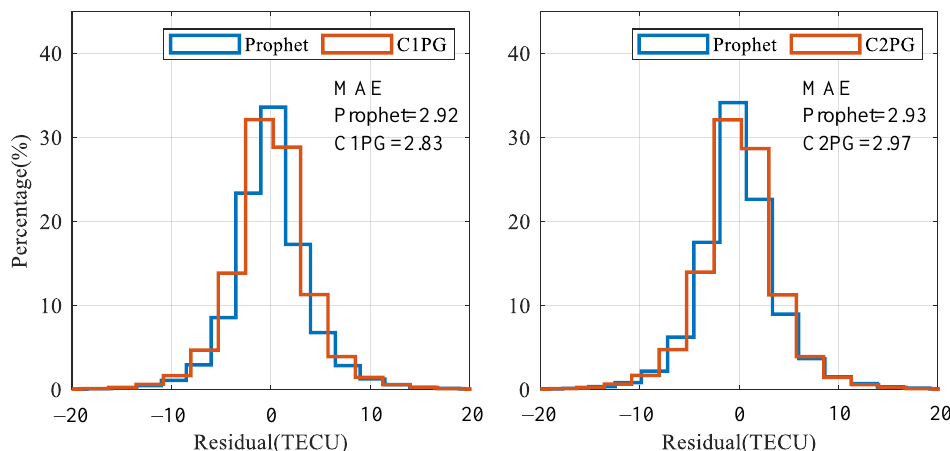
Figure 10. Forecasted residual distributions in a high-solar-activity year. Blue represents the Prophet model, and orange represents the COPG value.